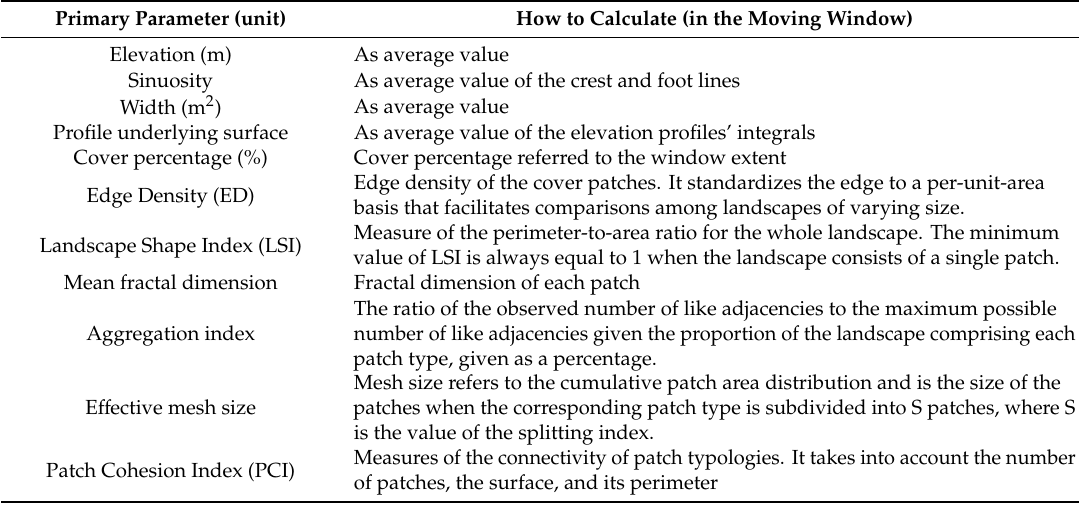
Table 4. Parameters generated for the continuous analysis